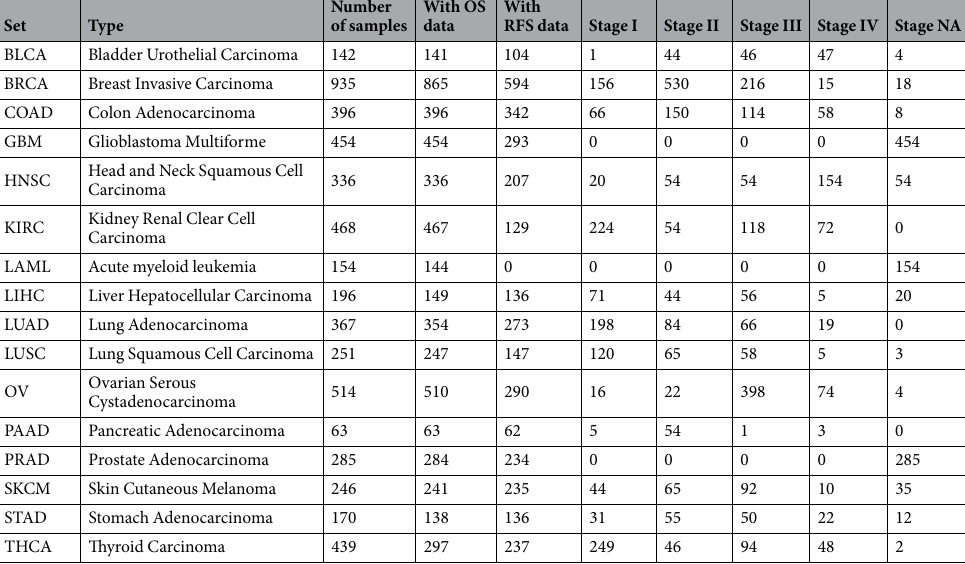
samples in them are described in Table 1. For cancer type, the distributions of baseline CN and percentage of genome altered was calculated for further use. LogR and BAF data could not be retrieved for 8 out of 5,416 samples. Baseline copy number and percentage of genome altered.